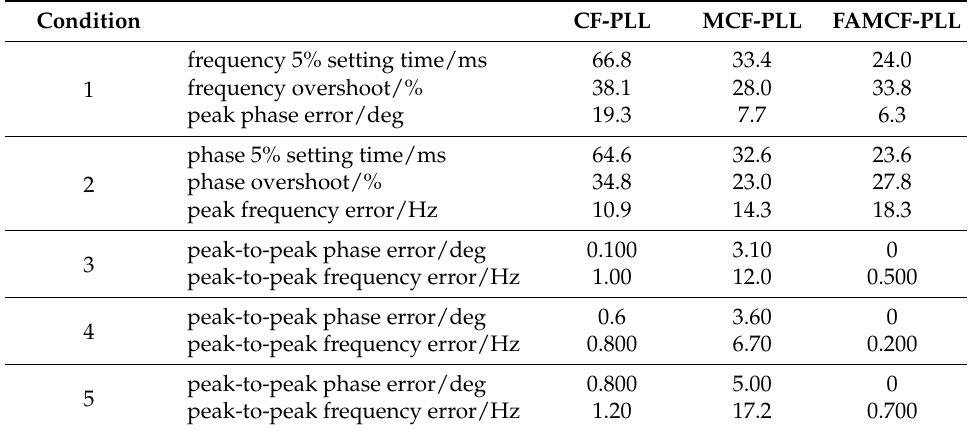
Table 1. Detailed experimental results of the PLLs.